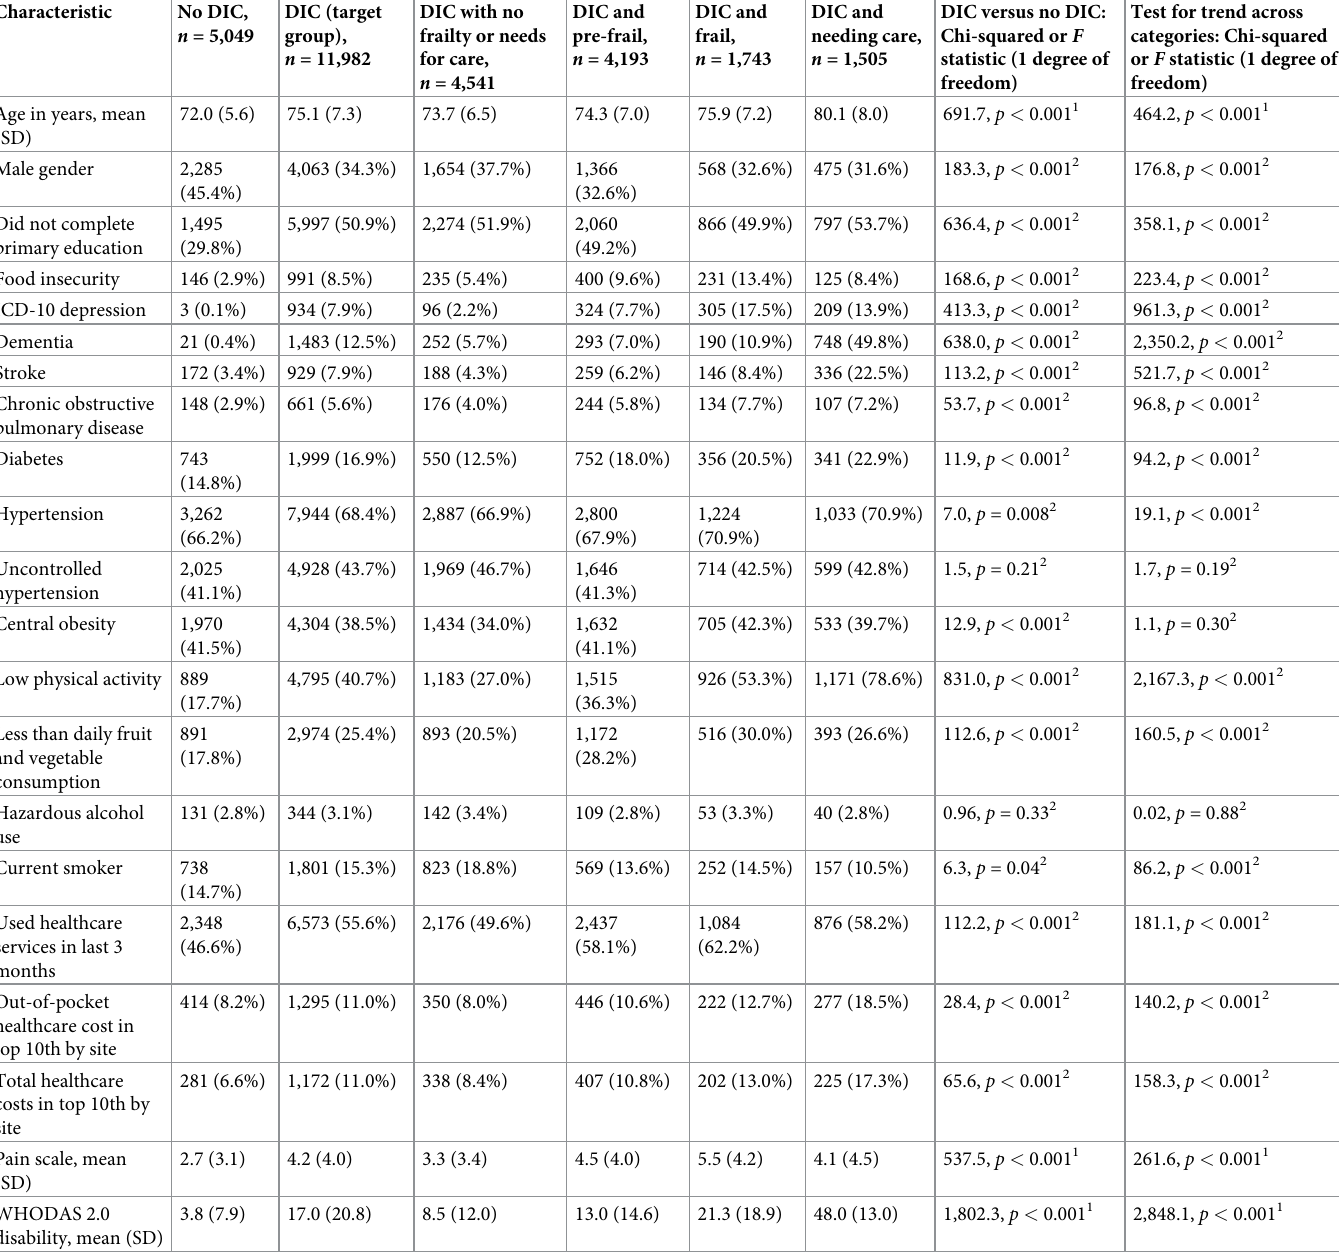
Table 3. Characteristics of the target group with DIC, further stratified by frailty and dependence (needs for care). Characteristic Test for trend across